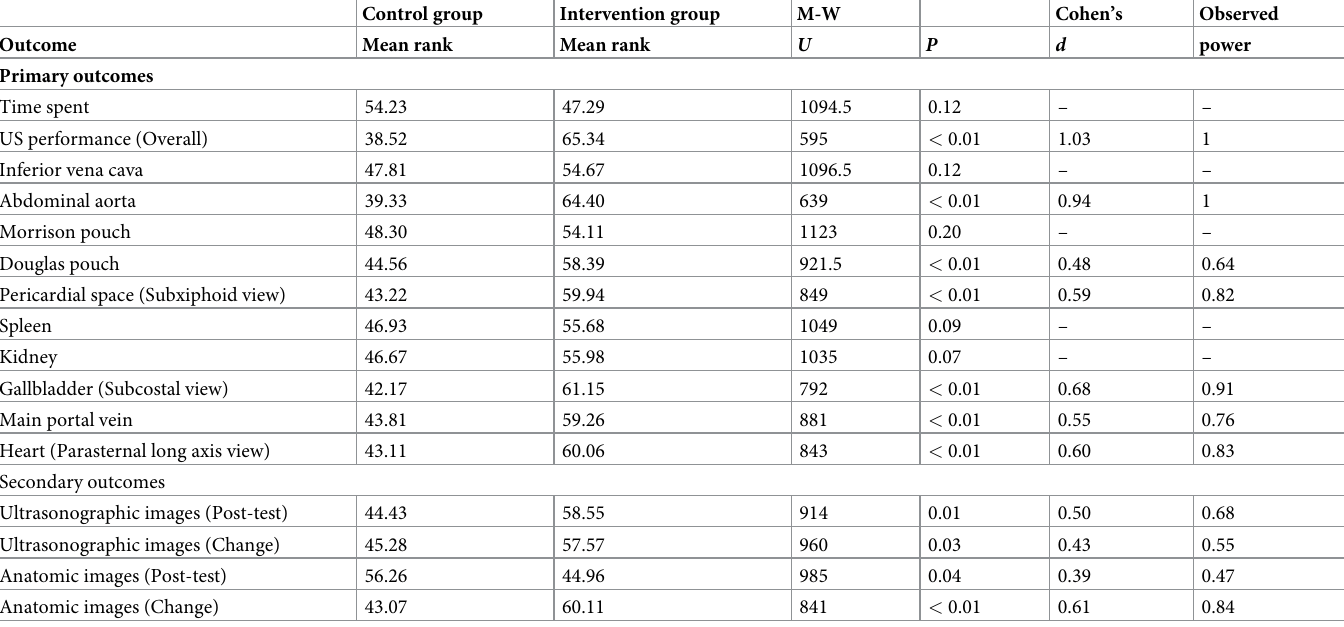
Table 2. Difference in primary outcomes and secondary outcomes between intervention group and control